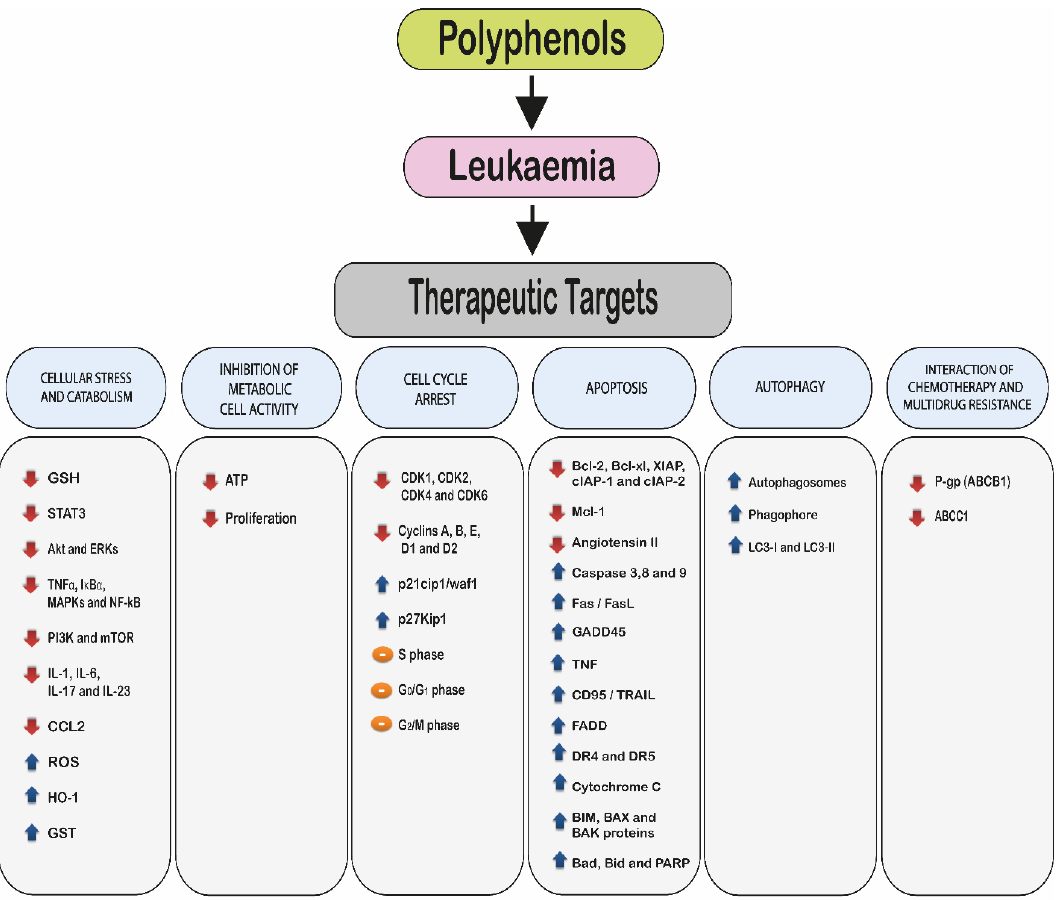
Figure 2. Molecular targets of polyphenols in leukaemia. The arrows represent changes in the levels and activities of genes and proteins. The red arrow shows an inhibition or reduction in gene expression and/or protein production, whilst the blue arrow shows an induction or increase gene expression and protein production. The orange sign indicates cell cycle arrest. The figure does not indicate any hierarchy.